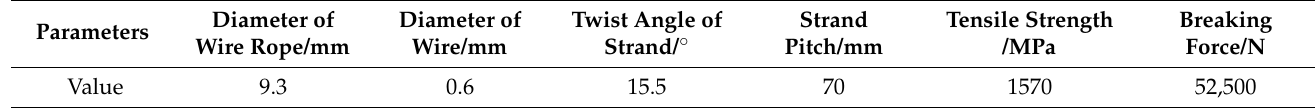
Table 3. Parameters of the wire rope.